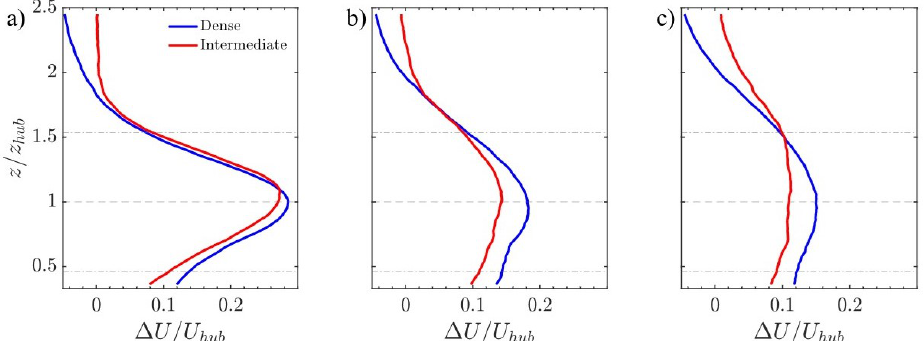
Figure 5. Vertical profiles of the time-averaged streamwise velocity deficit in the turbine wake, ∆ U = U ( z ) − U ( x , y = 0, z ) , at x / d T = ( a ) 3; ( b ) 5; ( c ) 7. The horizontal lines indicate the location inc of the hub, top and bottom tips of the turbine.